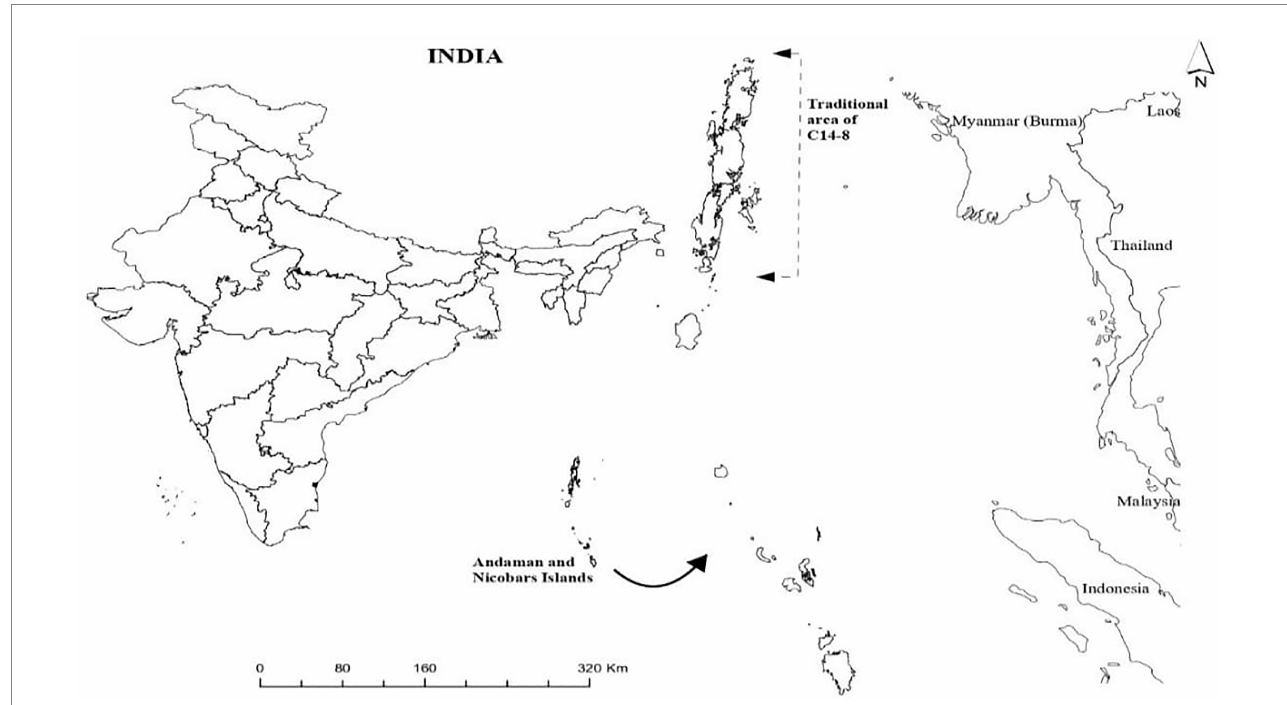
FIGURE 1 Map showing Andaman and Nicobar